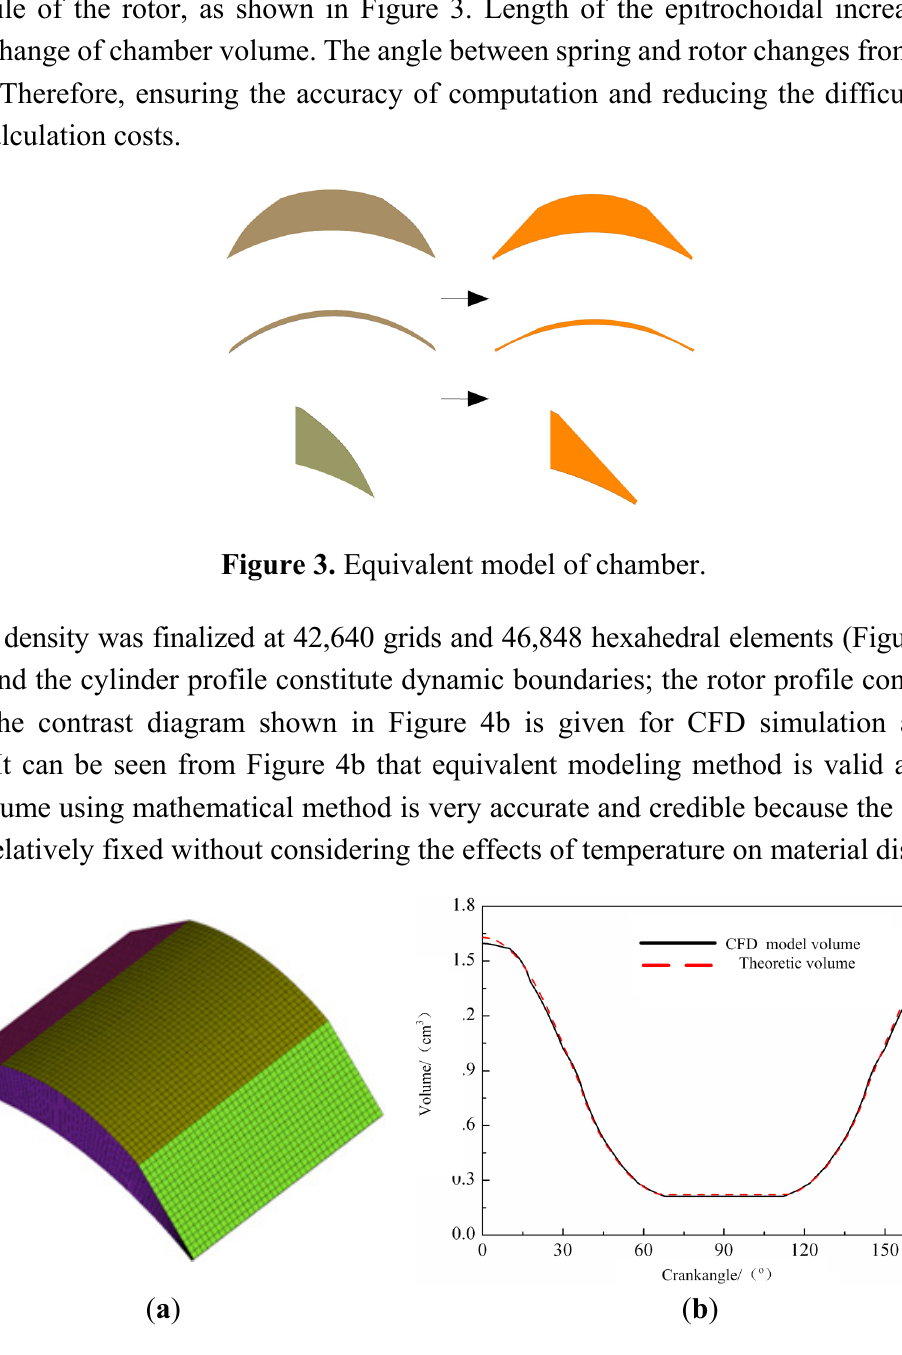
Figure 4. ( a ) Chamber mesh model; ( b ) Contrast diagram for CFD simulation and theoretical